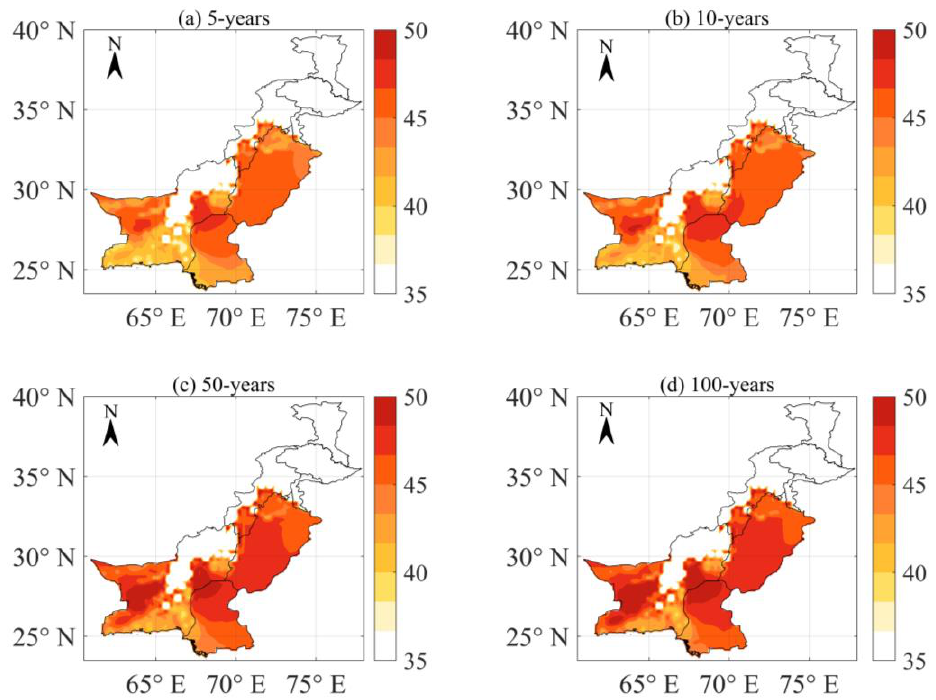
Figure 7. Spatial distribution of extreme high-temperature recurrence levels in CPEC: ( a ) 5a; ( b ) 10a; ( c ) 50a; ( d ) 100a.